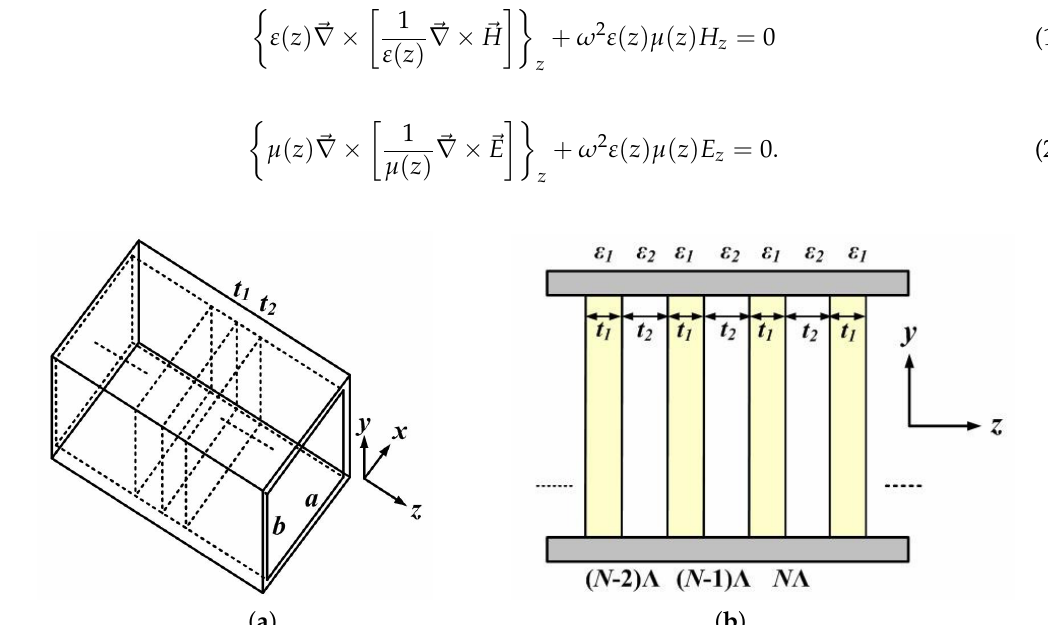
Figure 1. ( a ) 3D schematic of periodic multilayer heterostructure along the z -direction confined in a rectangular waveguide with a width a and a height b and ( b ) the corresponding dielectric function profile ε ( z ) in the cross-sectional